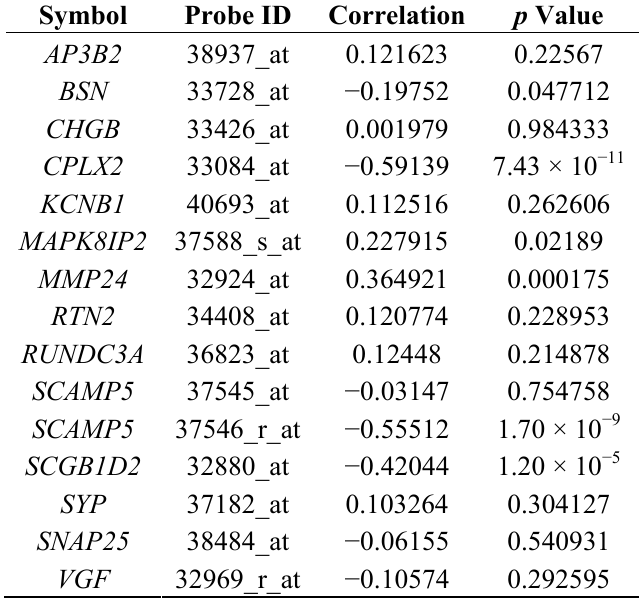
Table 2. Correlation of REST and REST signature genes in neuroblastoma